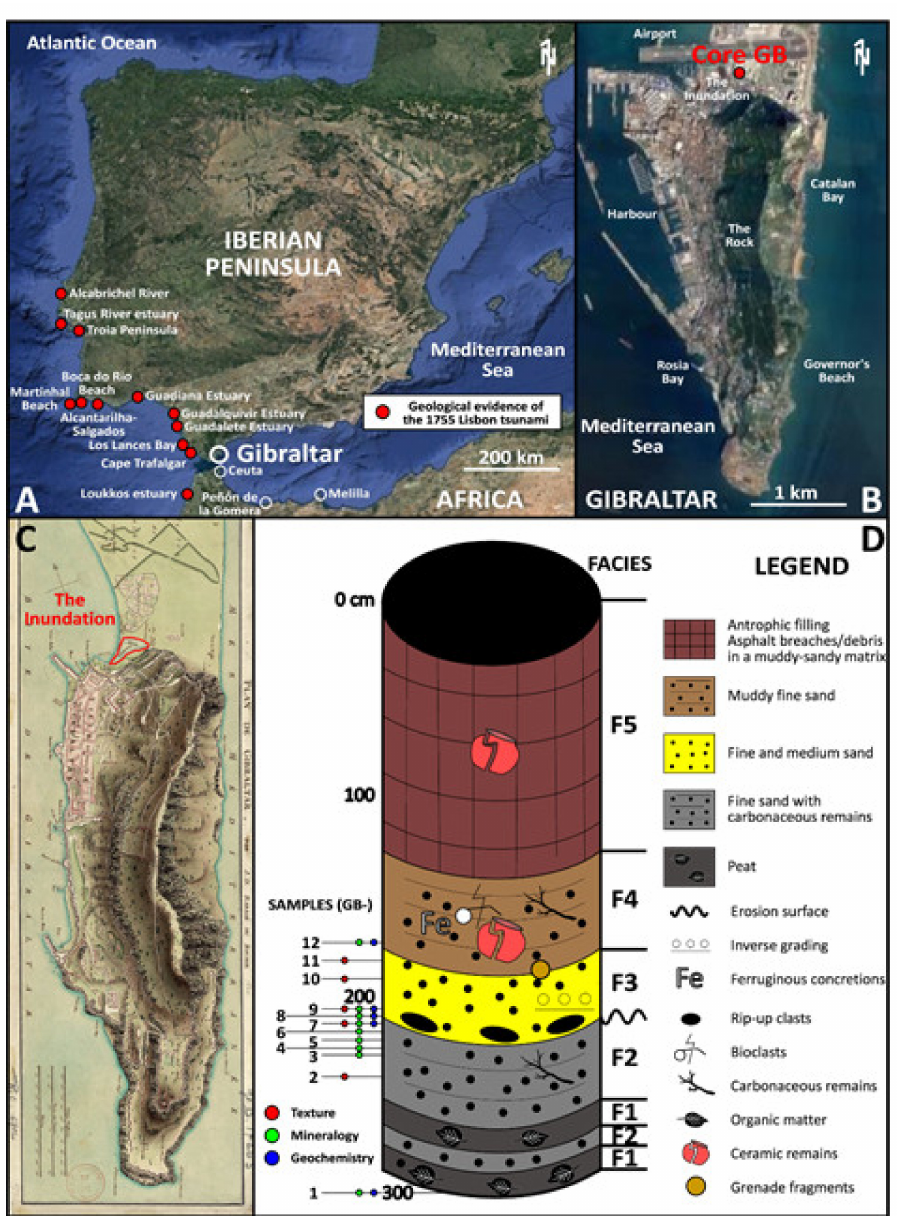
Figure 1. ( A ) Geological evidence of the 1755 Lisbon tsunami along the Atlantic coasts of Portugal, Spain, and Morocco; ( B ) the Rock of Gibraltar: location of core GB; ( C ) Gibraltar: historical map of 1799; ( D ) log of core GB, including sampling and facies